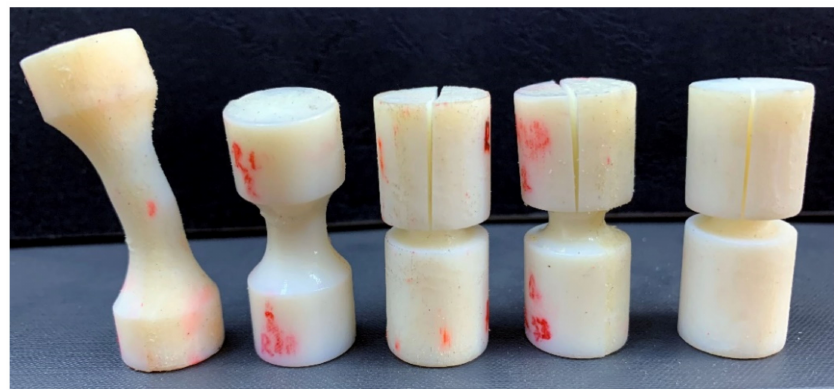
Figure 9. Specimen condition after the compressive tests.